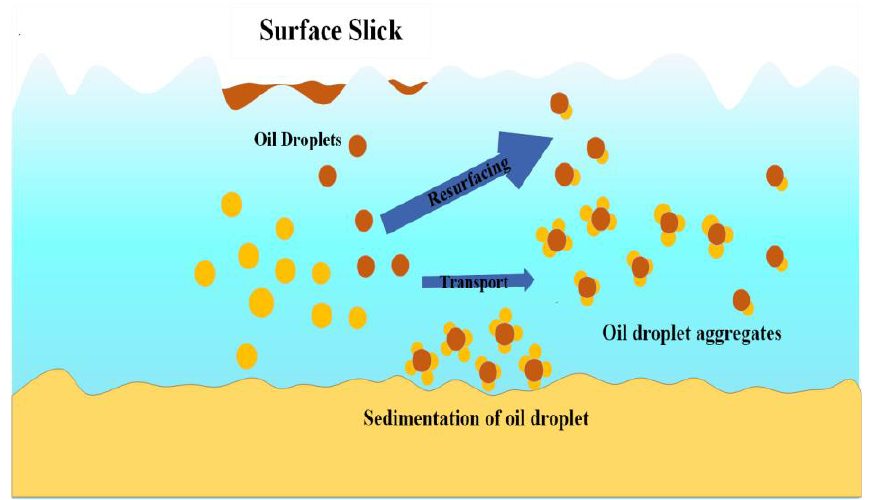
Figure 6. Conceptual model of oil particle aggregate.